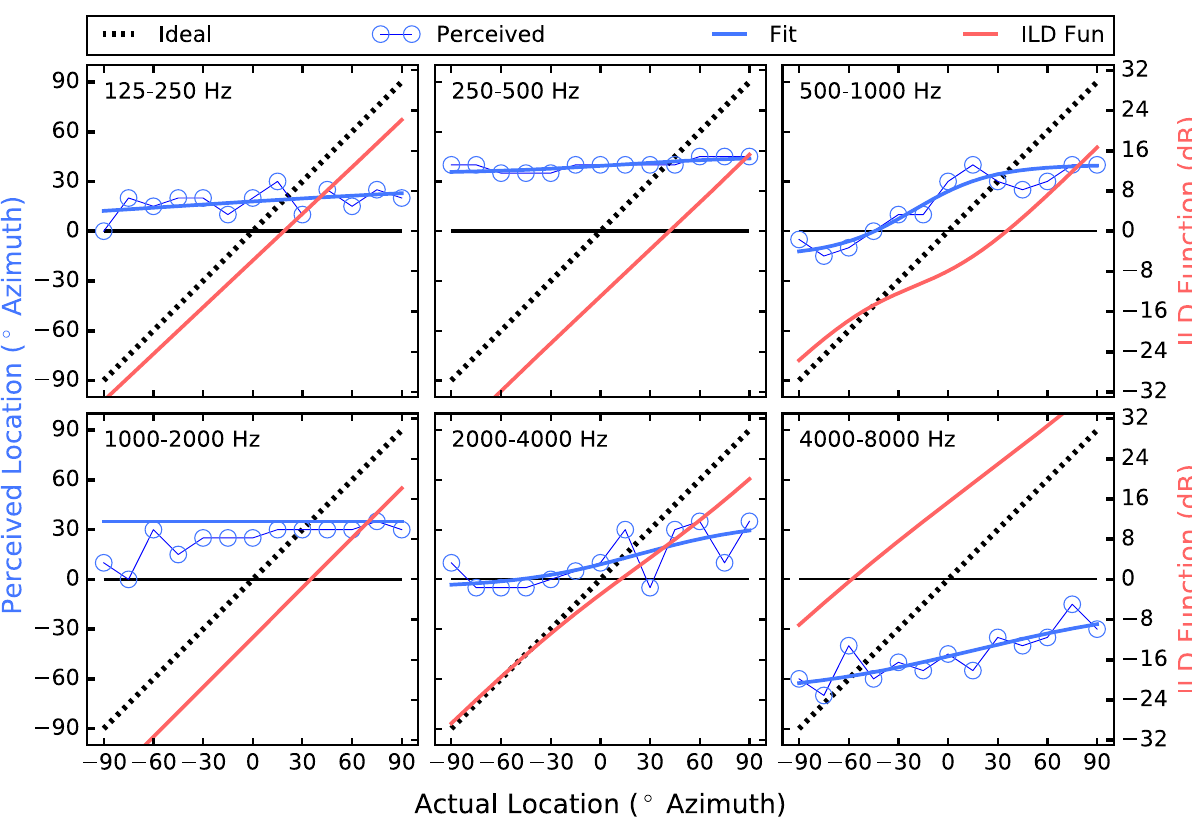
Fig 2. Corrective ILD generation data for participant 2243. The layout is identical to that of Fig